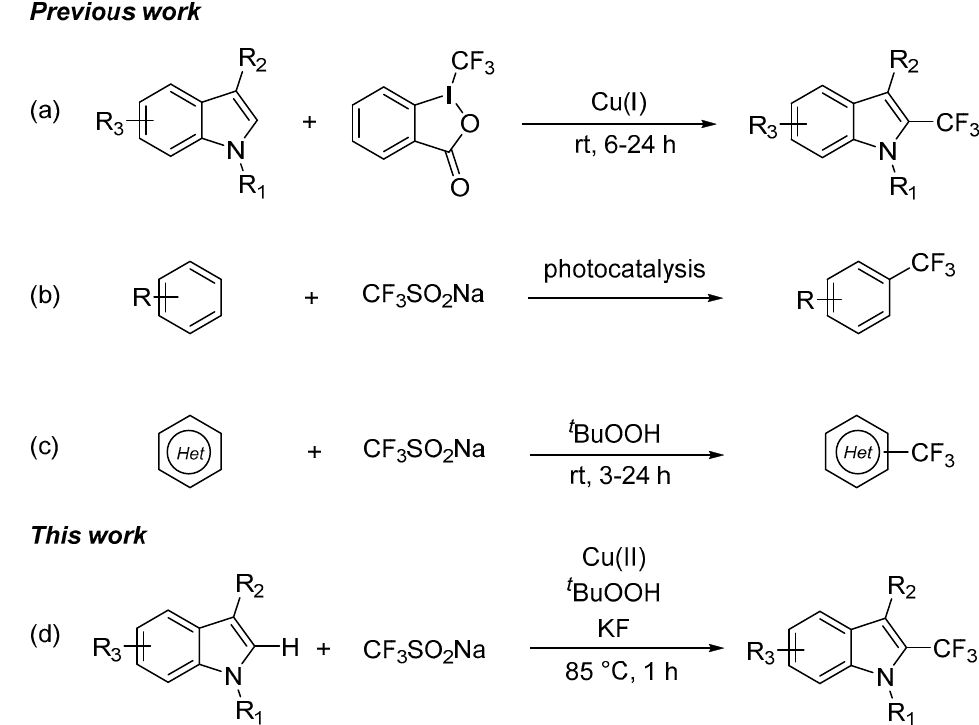
Table 1. Optimization of the reaction conditions a